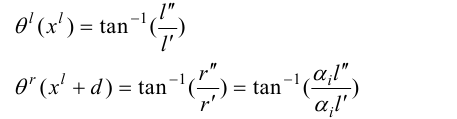
Left image Right image a